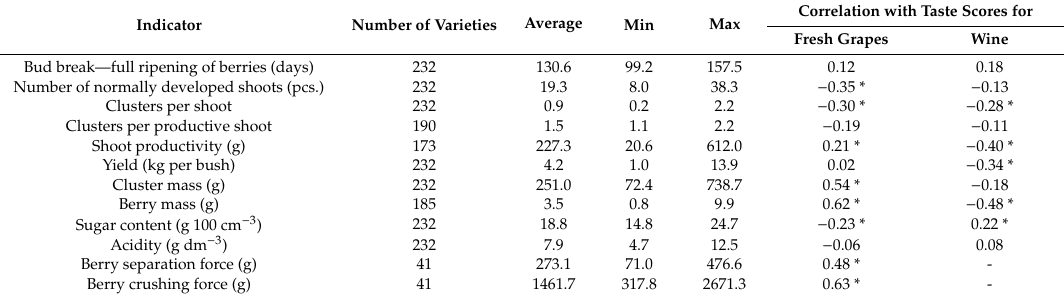
Table 2. Correlations between taste scores and agrobiological indicators of varieties.